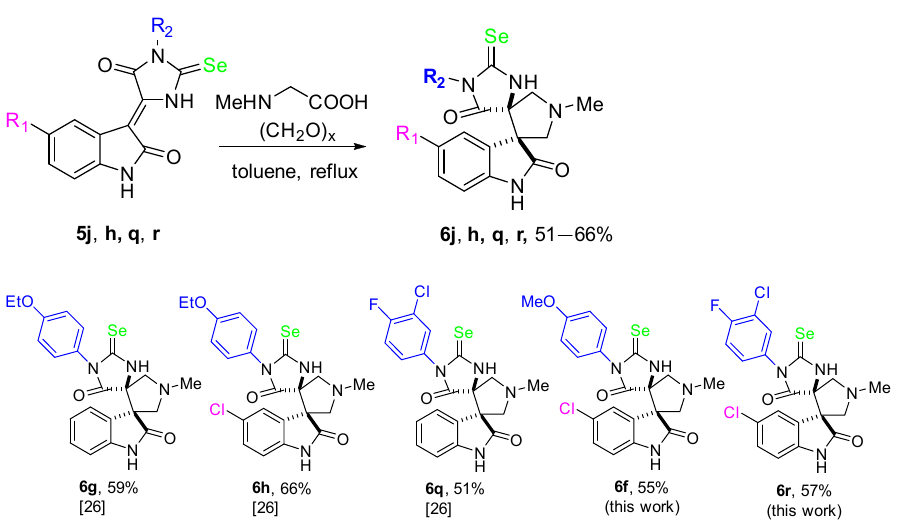
Scheme 3. Synthesis of Se-containing analogue of the compounds 4 .